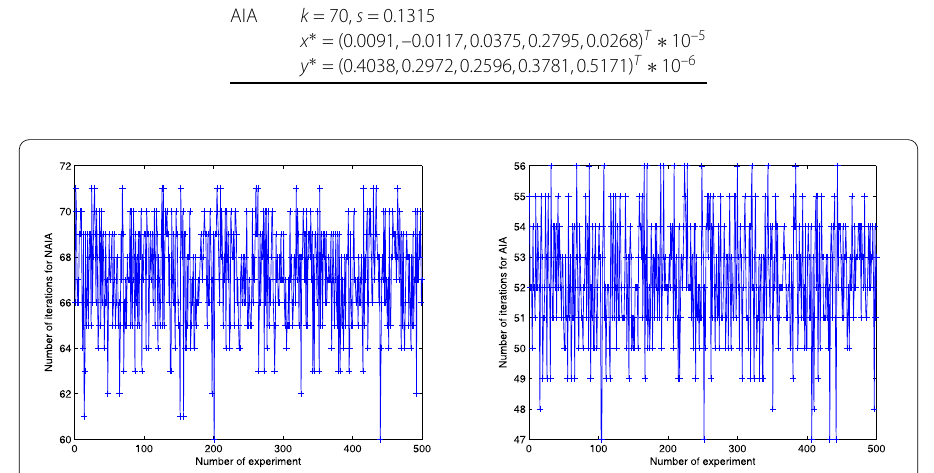
Figure 1 The iterative number of NAIA and AIA for the initial point of Case 1